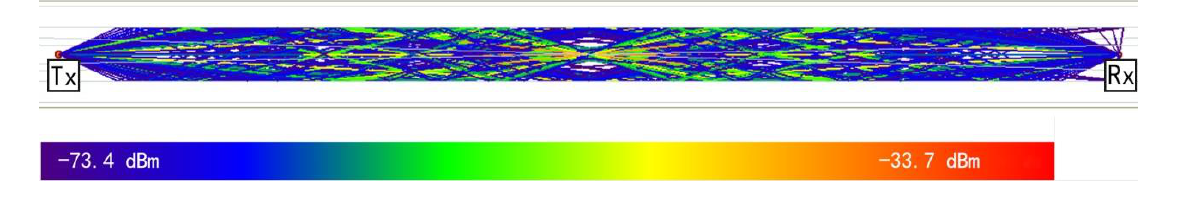
Figure 6. Multipath Signal Propagation Path.